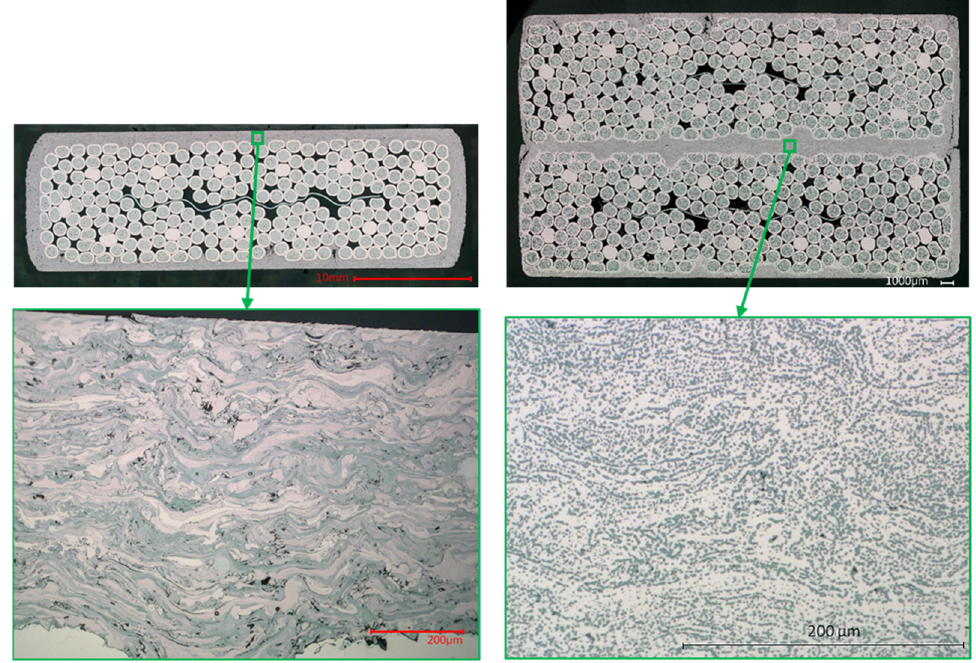
Figure 8. Form of the Cu oxides before ( left ) and after ( right ) the diffusion-bonding heat treatment.